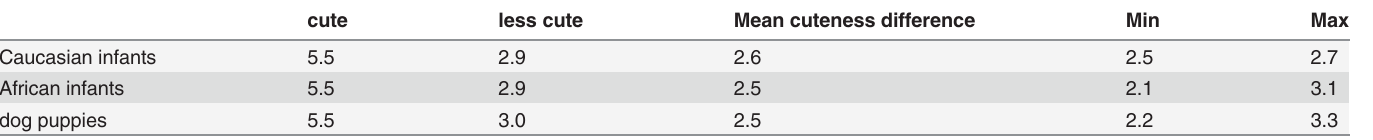
Table 1. Mean cuteness scores of the stimuli used in Study